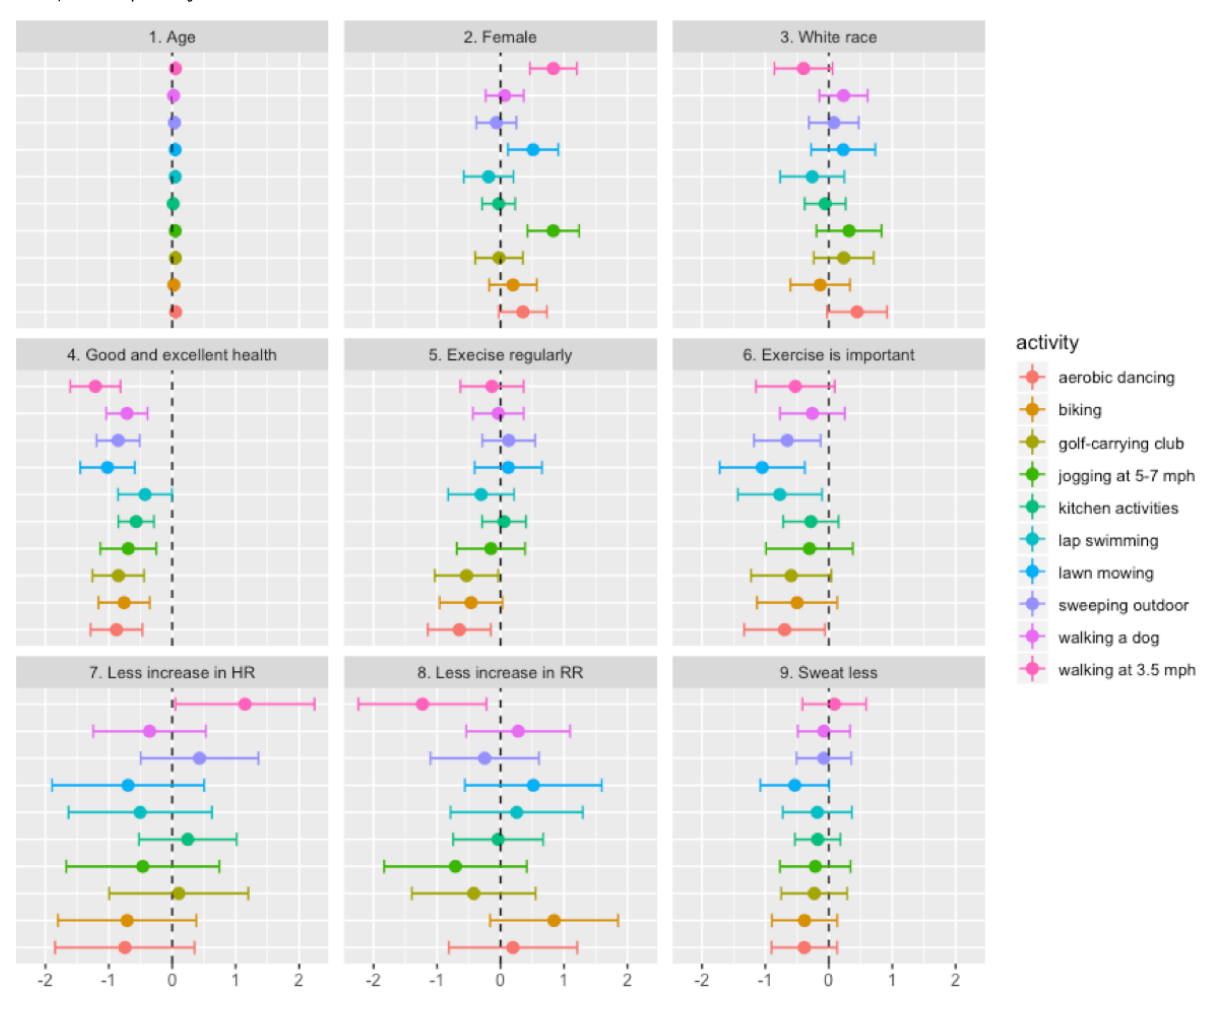
Figure 4. Regression coefficients and 95% CIs of the participants’ characteristics in predicting the intensity ratings of the 10 activity examples. HR: heart rate; RR: respiratory